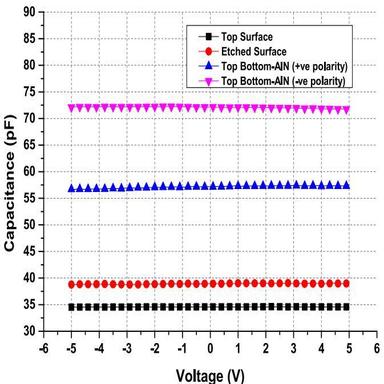
Capacitance voltage analysis of AlN stack.